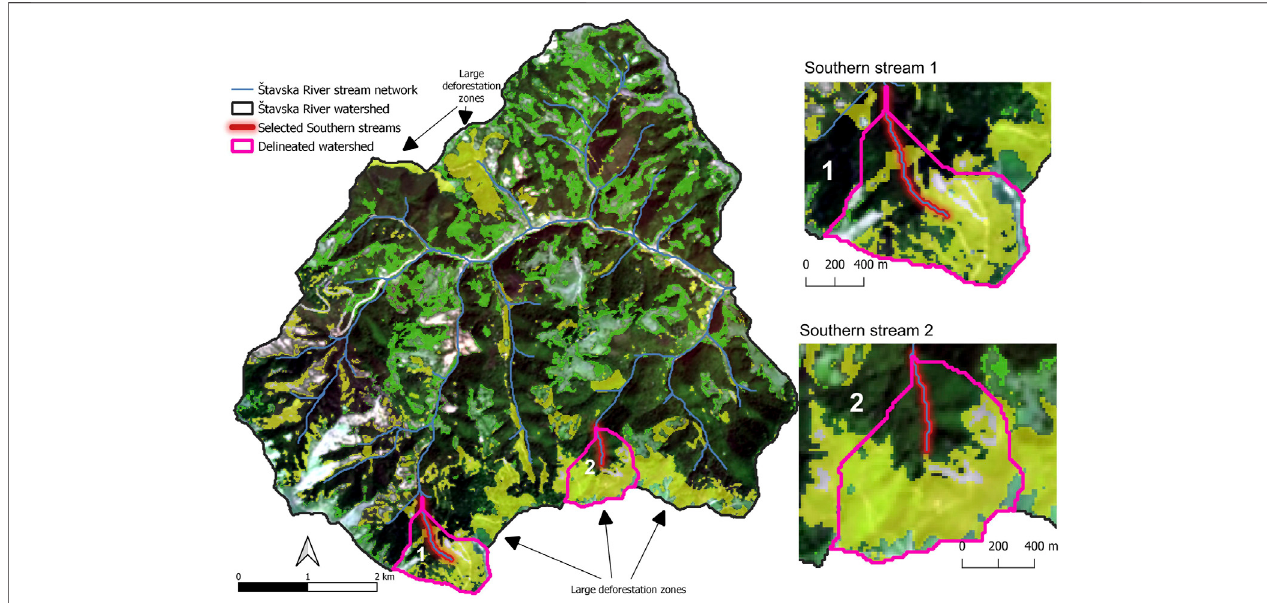
FIGURE 4 | Š tavska River selected Southern mountainous streams.